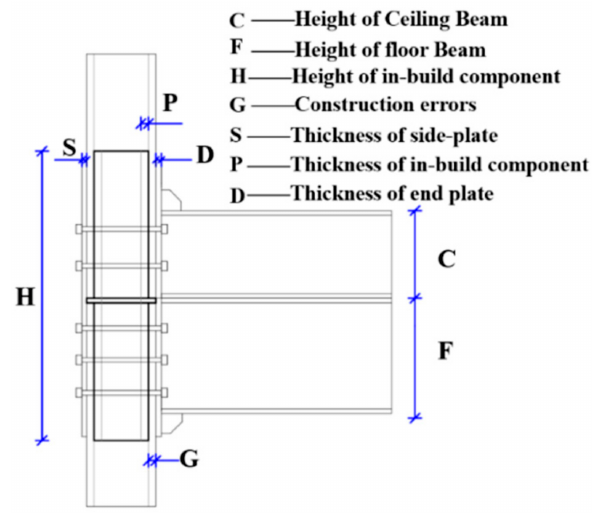
Figure 6. Parameters setting of finite element model.